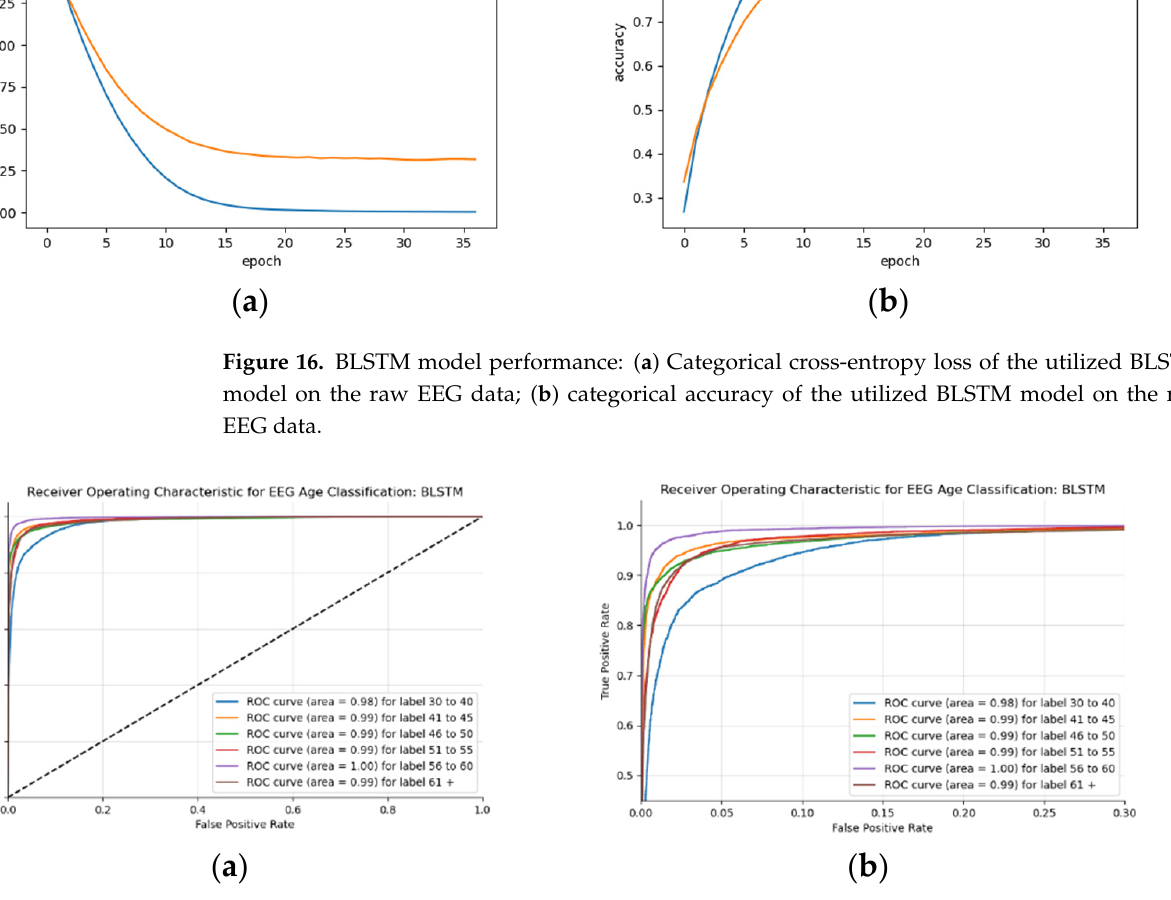
Figure 17. ROC of the utilized BLSTM model on the raw EEG data: ( a ) full ROC figure; ( b ) zoomed in portion to illustrate the initial characteristics of the experiment.